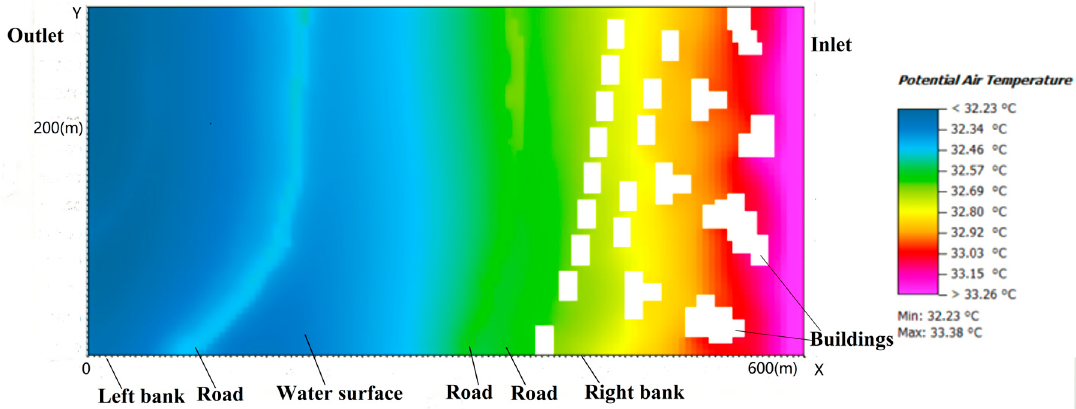
Figure 6. Air temperature distribution of the study area at 16: 00.